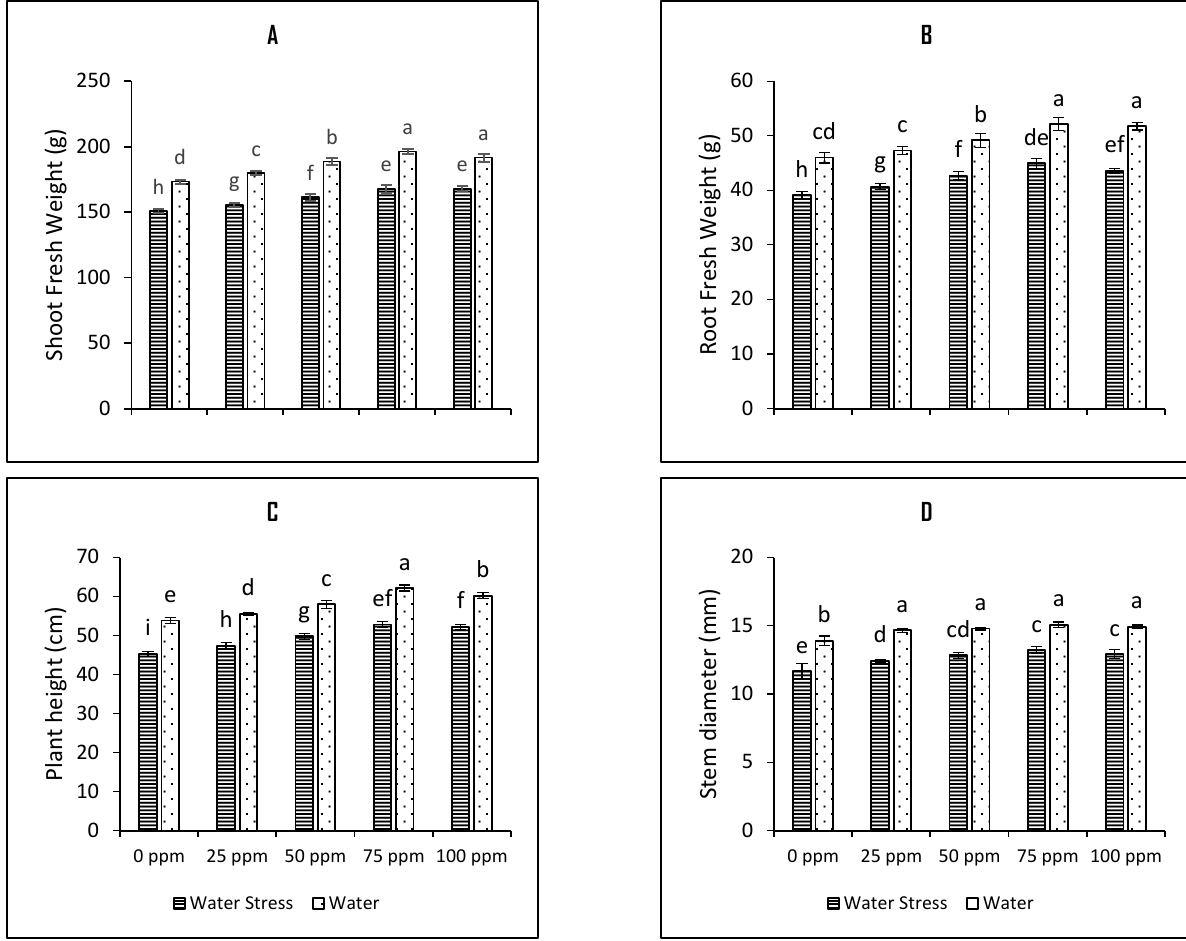
Figure 1. Bar charts (mean ± S.E; n = 3) representing growth attributes ( A ) shoot fresh weight ( B ) root fresh weight ( C ) plant height and ( D ) stem diameter of tomato plants raised from SeNPs-primed seeds grown under water stress and water conditions. 0, 25, 50, 75, and 100 ppm on x -axis represent concentrations of Se-NPs followed in the seed priming experiment. Bars with different alphabets represents mean data which signi fi cantly di ff ers at ( p < 0.05).